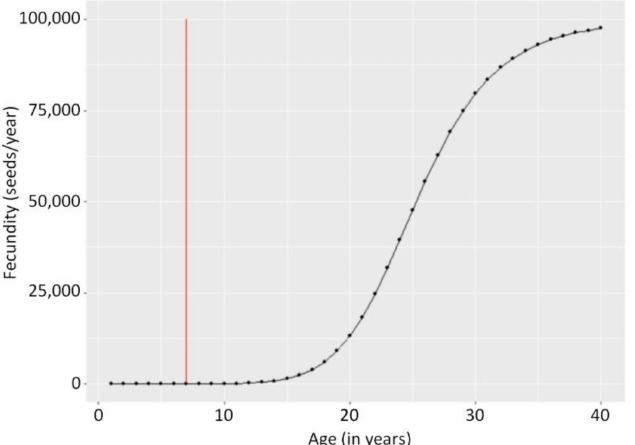
Figure A1. An example of the fecundity of a perennial plant as a function of the plant’s age (ˆ k = 7 as represented by the red vertical line, i.e., age of reproductive maturity, M = 100,000, θ =